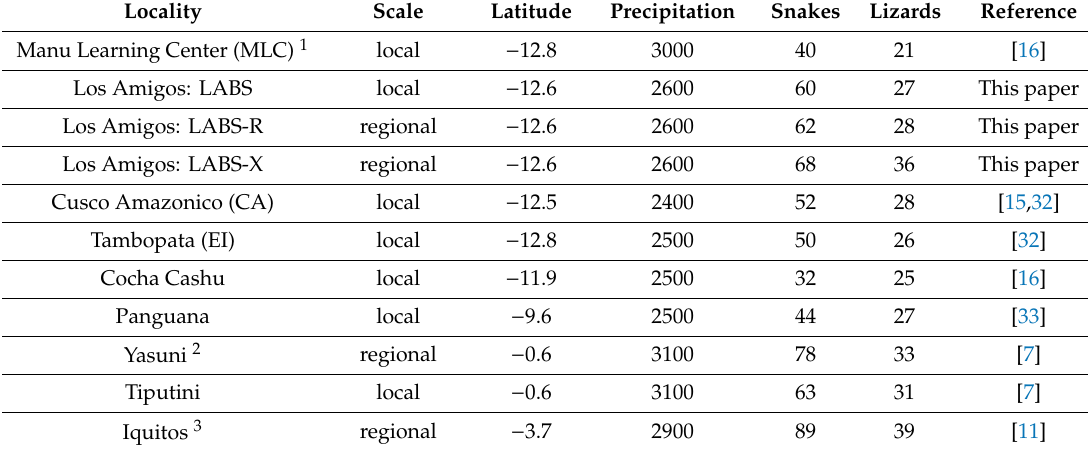
Table 1. Species richness for lizards and snakes for selected sites in the western Amazon basin. Localities are shown in Figure 2. LABS, LABS-R, and LABS-X are documented and estimated richness totals for Los Amigos Biological Station, as in Table